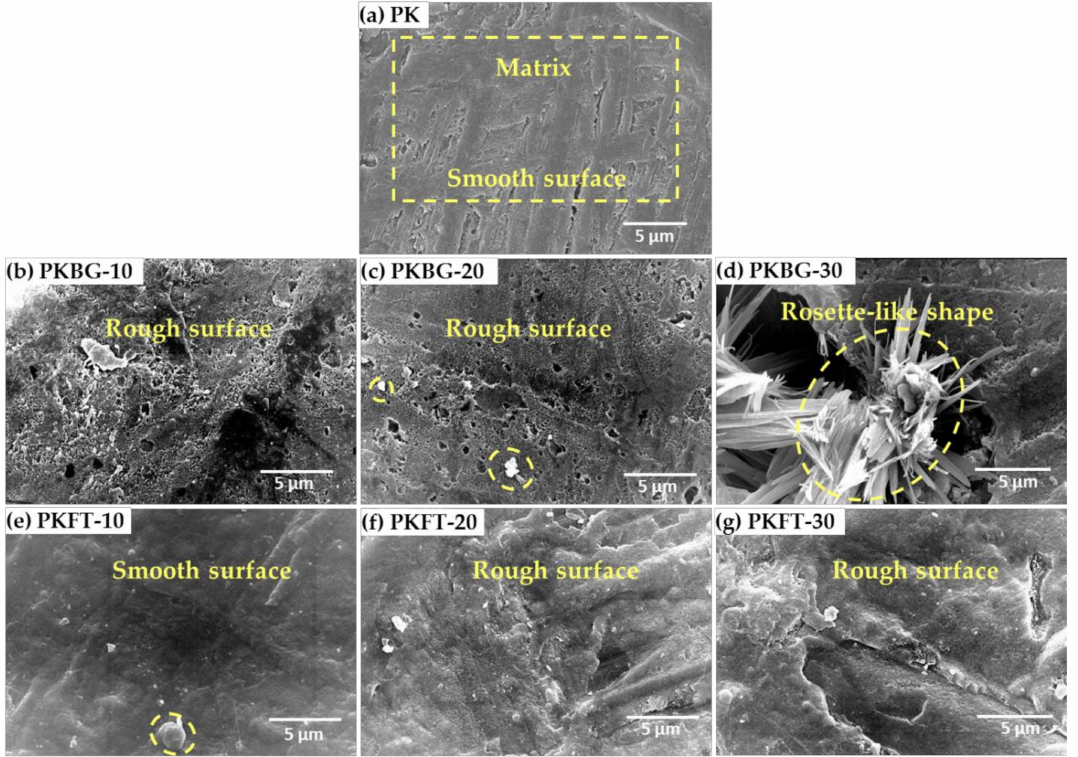
Figure 2. SEM micrographs of the surface morphologies showing details of smooth and rough regions for pure PEEK and PEEK nanocomposites loaded with different content (10, 20, 30 wt.%) of BG and FT nanofillers: ( a ) smooth PEEK, ( b , c ) rough PKBG-10 and PKBG-20, ( d ) rough agglomeration of BG nanoparticles on PKBG-30, ( e ) smooth PKFT-10, and ( f , g ) low rough PKFT-20 and PKFT-30 with randomly distributed FT nanoparticles within the PEEK